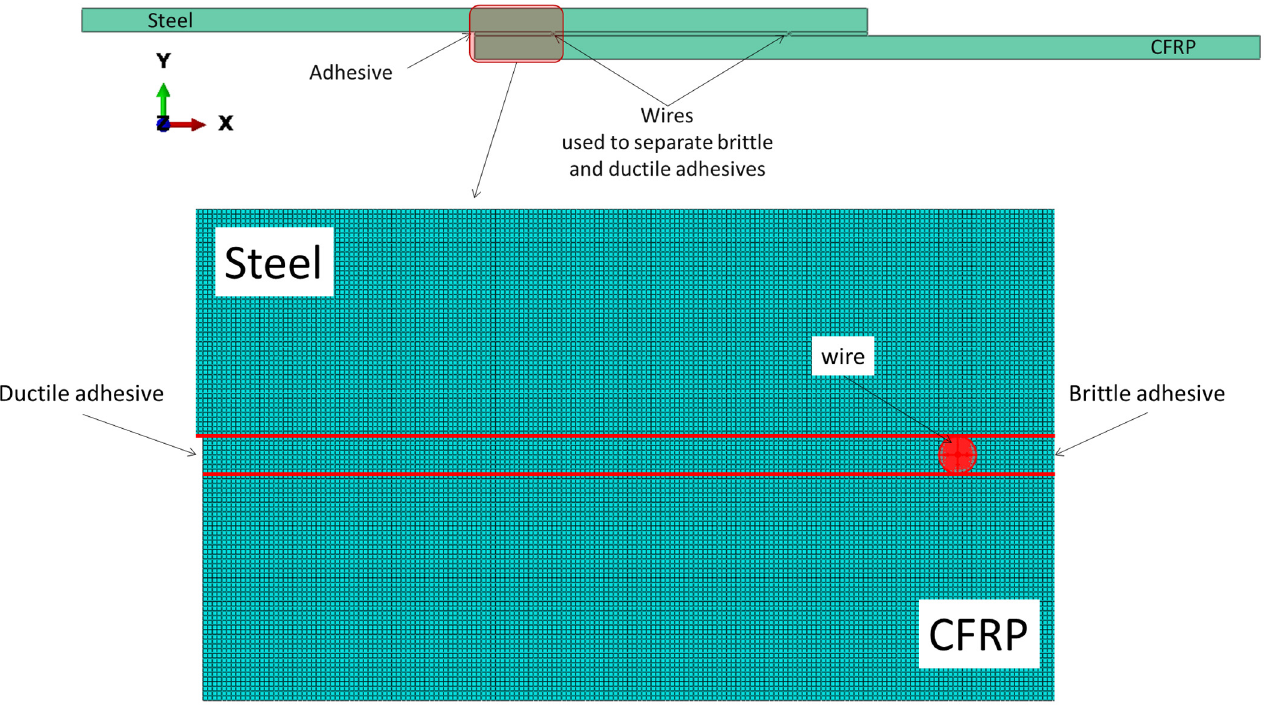
Figure 4. Simulated SLJ and the considered mesh configurations.